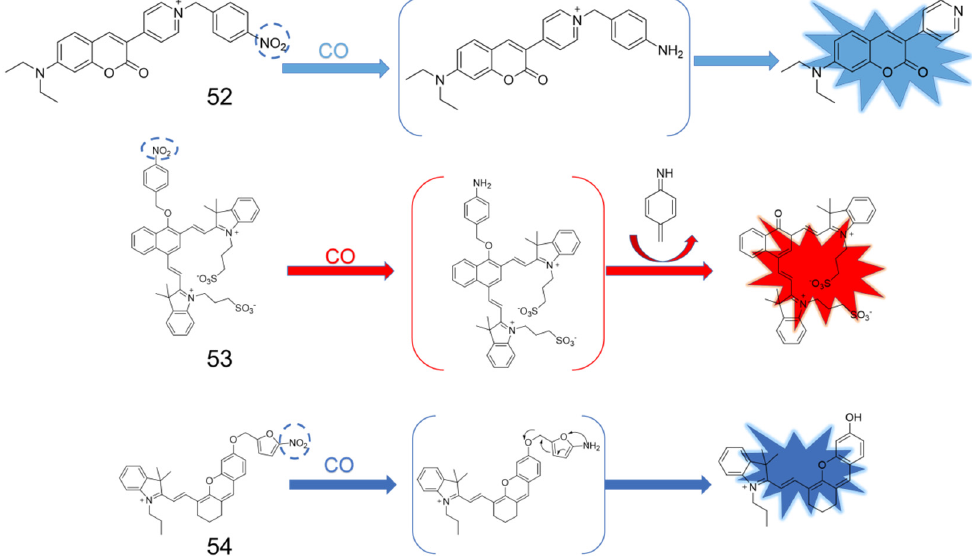
Figure 19. Some other fluorescent probes for the detection of CO and their sensing mechanisms based on nitro.